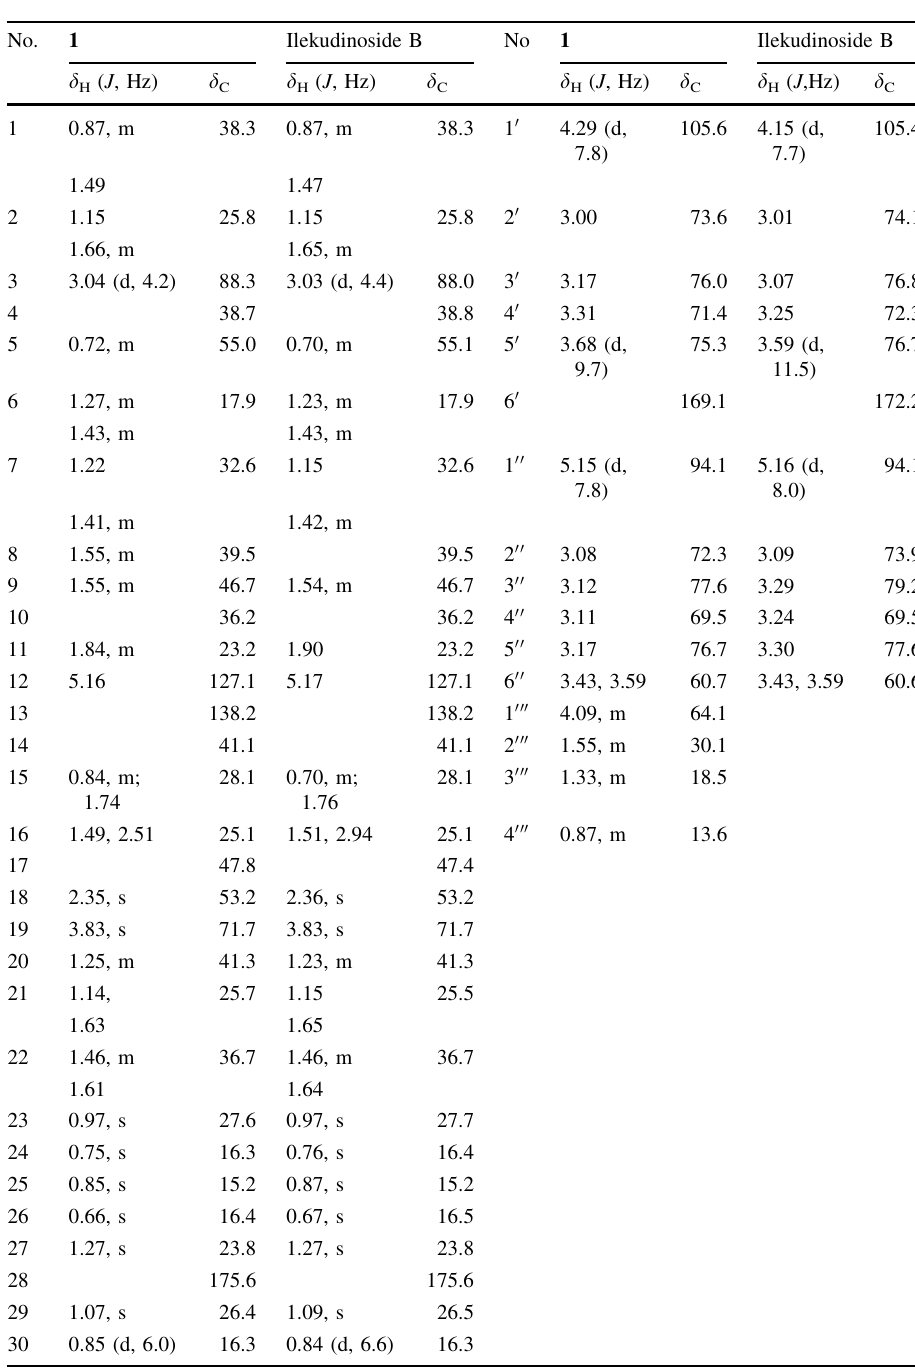
No. 1 Ilekudinoside